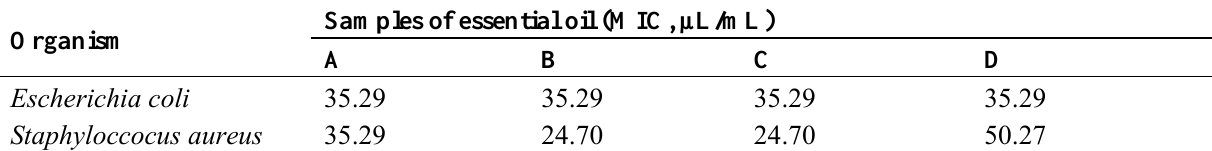
Table 4. Antimicrobial activity of the essential oils of the four samples given as minimum inhibitory